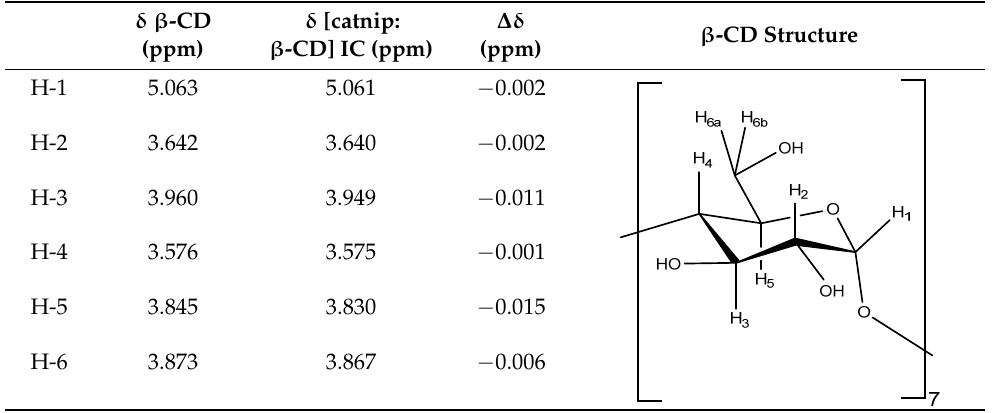
Figure 3. FT-IR spectra of catnip essential oil (EO), β -cyclodextrin ( β -CD), their physical mixture (PM), and their inclusion complexes (IC). Table 3. Chemical shift ( δ ) and corresponding changes ( Δδ ) between the 1 H-NMR spectra of β -CD and the [catnip: β -CD] inclusion complex (IC). Protons are labelled according to the β -CD structure.